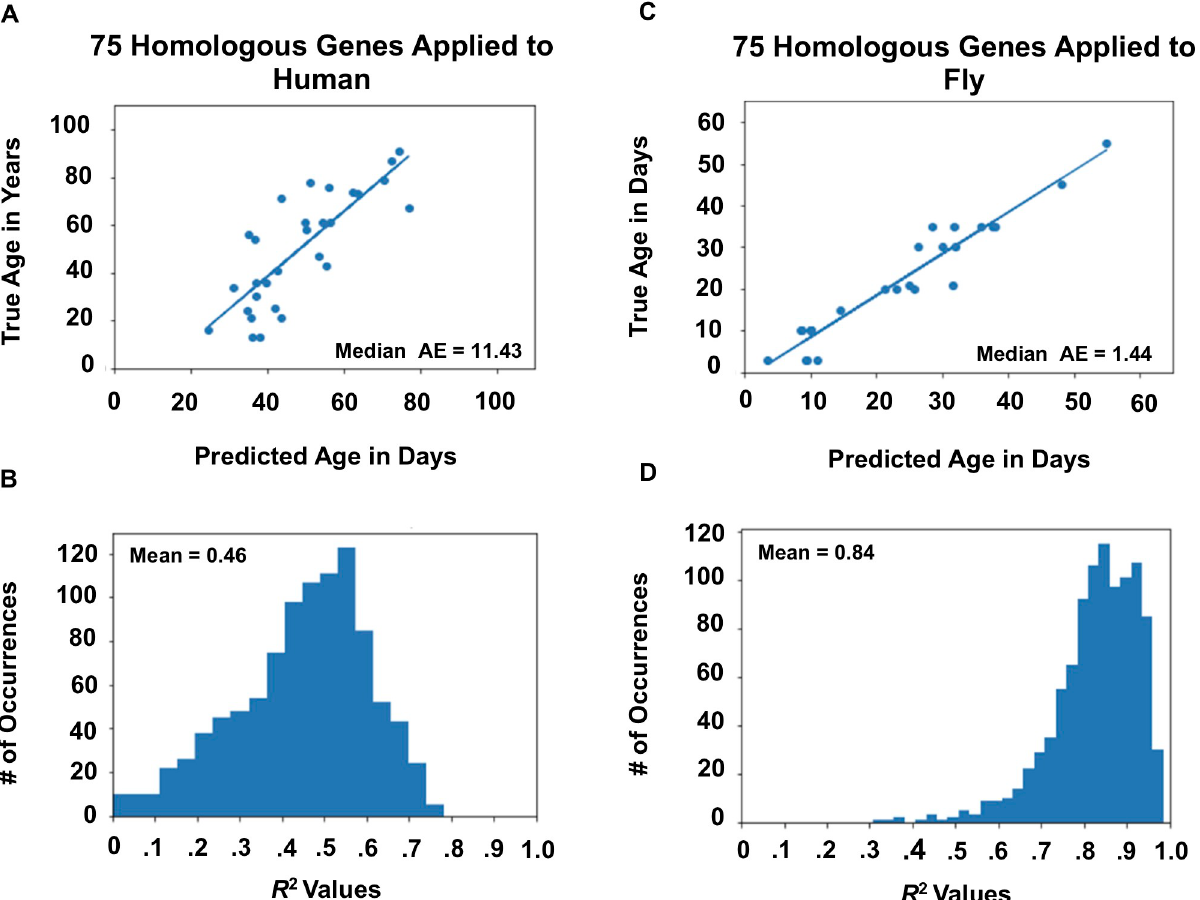
Fig 3. Feature selection using aging correlated genes across species. A) Sample regression analysis using the top 1000 human aging correlated genes to predict human age. B) Histogram of R 2 values using the top 1000 human aging correlated genes to predict human age with a mean R 2 of 0.62. C) Sample regression analysis predicting Drosophila age using the top 1000 aging correlated Drosophila genes. D) Histogram of R 2 values predicting Drosophila age using the top 1000 Drosophila aging correlated genes with mean R 2 of 0.95. All results calculated using XGBoost. All histograms represent averages across 1000 bootstrapped random samplings where the regressor or classifier was trained on 75% of the samples and tested on 25%. All histogram values are reported as the mean across 1000 iterations. Median AE stands for median average error.